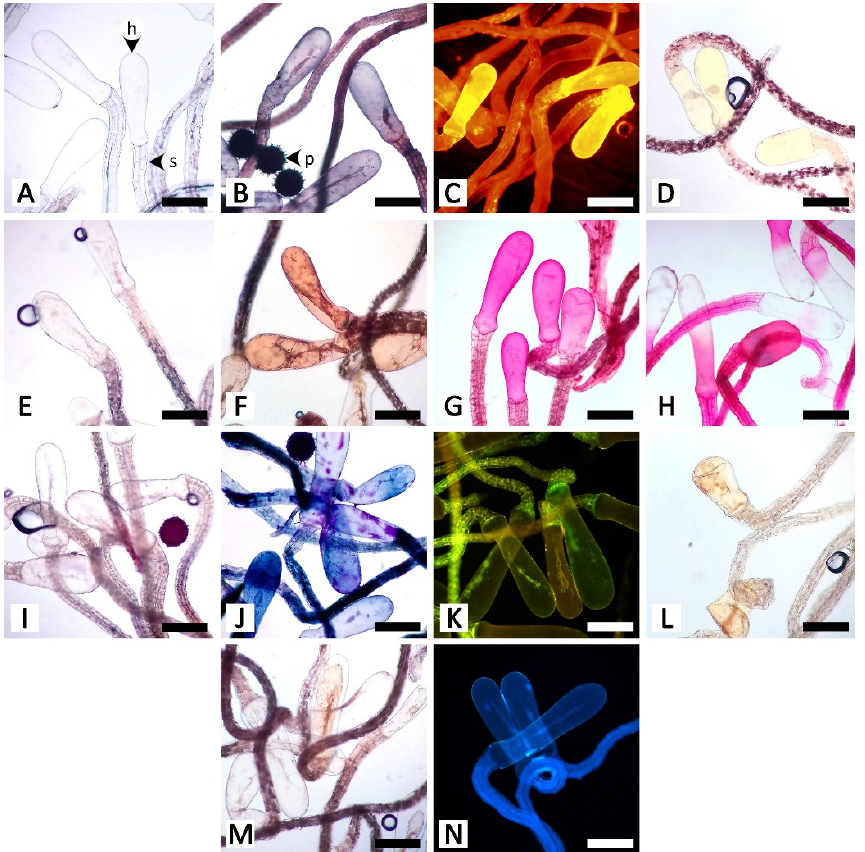
Figure 9. Histochemical results obtained from staminal hairs of Rivea ornata . ( A ) Unstained staminal hairs. ( B ) Sudan black B test for total lipids. ( C ) Neutral red fluorochrome test for total lipids. ( D ) Ferric chloride test for phenolic compounds. ( E ) Potassium dichromate test for phenolic compounds. ( F ) Lugol’s iodine test for starch. ( G ) Periodic acid–Schiff’s reagent (PAS) test for neutral polysaccharides. ( H ) Ruthenium red test for acidic polysaccharides. ( I ) Mercuric bromophenol blue test for proteins. ( J ) Nadi reagent test for terpenoids. ( K ) Naturstoff reagent A under fluorescent microscopy detecting flavonoids. ( L ) Dragendorff reagent test for alkaloids. ( M ) Wagner’s reagent test for alkaloids. ( N ) UV autofluorescence of staminal hairs. Note: ( B – E , G , H , J – M ) show positive reactions, while ( F , I ) show negative reactions. Abbreviations: h, head; p, pollen grain; s, stalk. Scale bars 200 μ m.